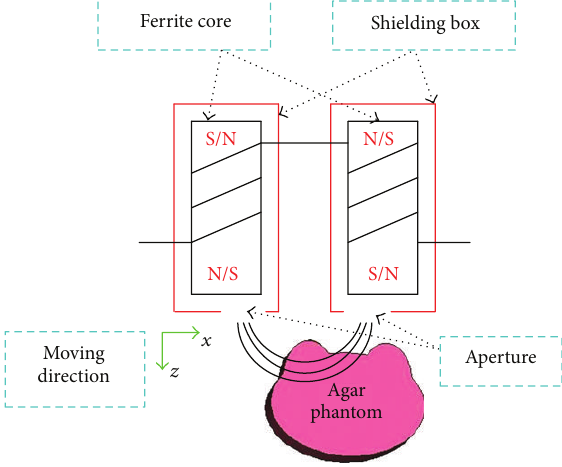
Figure 1: Schematic of shielding system. The shielding system consists of two rectangular shielding plates and controls the vertical by enclosing the ferrite core with a rectangular shield with